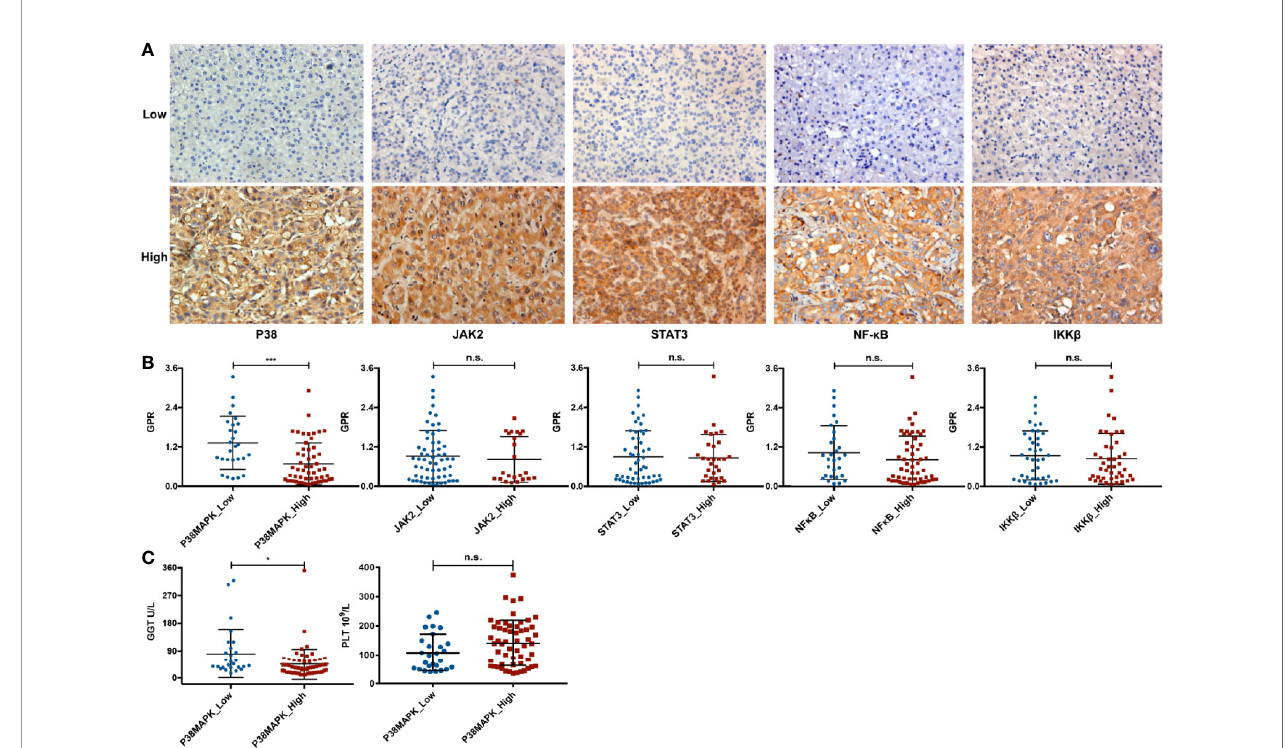
FIGURE 8 | The relationship between the GPR and in fl ammation-related signaling pathways. (A) representative immunohistochemistry images of the P38MAPK, JAK2, STAT3, NF k B, and IKK b proteins in HCC tissue specimens (400×). (B) the comparison between the above fi ve key in fl ammation-related factors and the GPR. (C) the comparison between P38MAPK expression and GGT or PLT levels. P38MAPK, p38 mitogen-activated protein kinase; JAK2, janus kinase 2; STAT3, signal transducer and activator of transcription 3; NF k B, nuclear factor kappa-light-chain-enhancer of activated B cells; IKK b , inhibitor kappa B kinase b ; GPR, gamma ‐ glutamyl transpeptidase ‐ to ‐ platelet ratio; GGT, gamma-glutamyl transpeptidase; PLT, platelet; HCC, hepatocellular